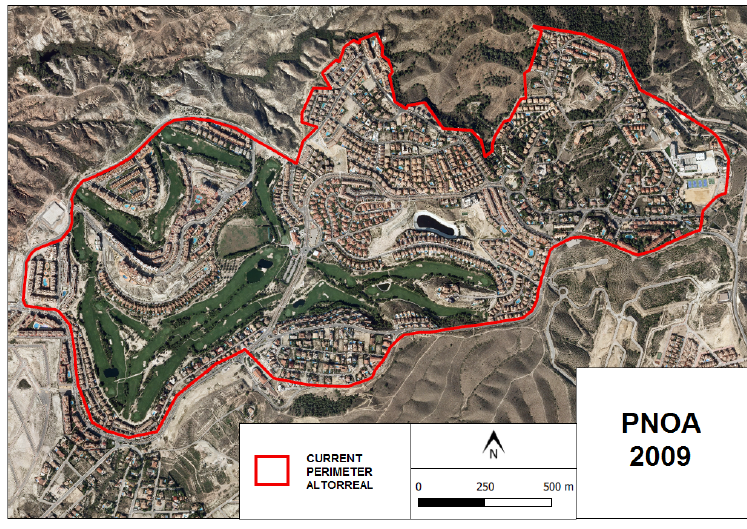
Figure 7. View of the Altorreal resort in 2009 at the end of the building process.